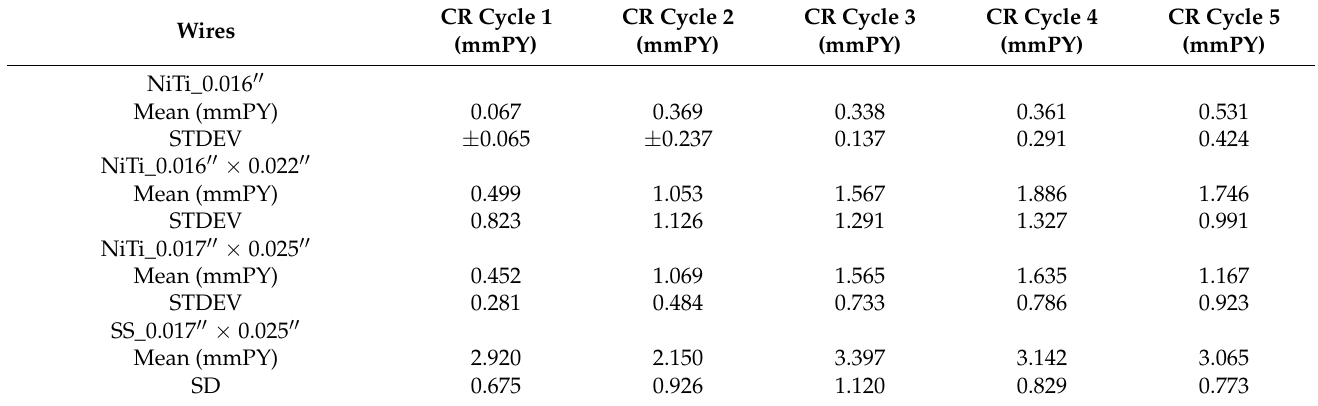
Table 4. The results for the corrosion rate (CR) at each of the five